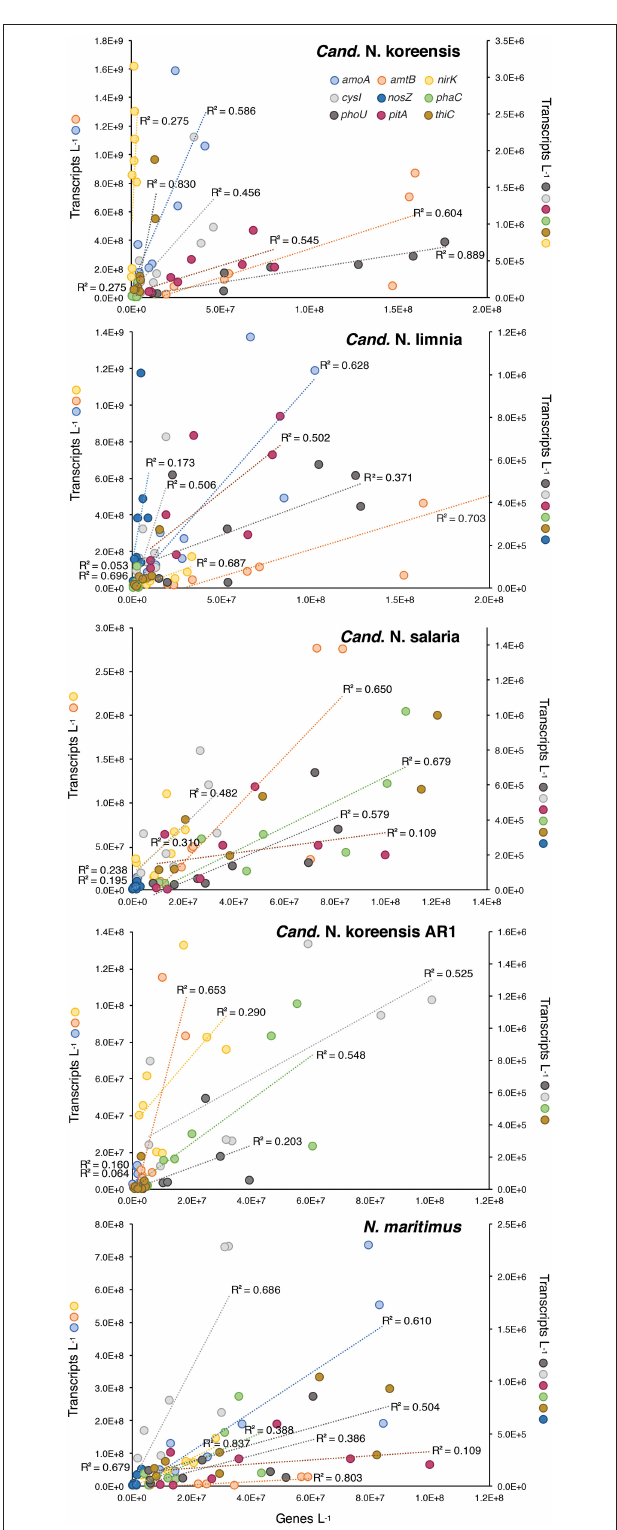
FIGURE 5 | Plot of transcripts L − 1 vs. genes L − 1 for nine highly expressed element cycling genes in five homogeneous archaeal genome bins at stations